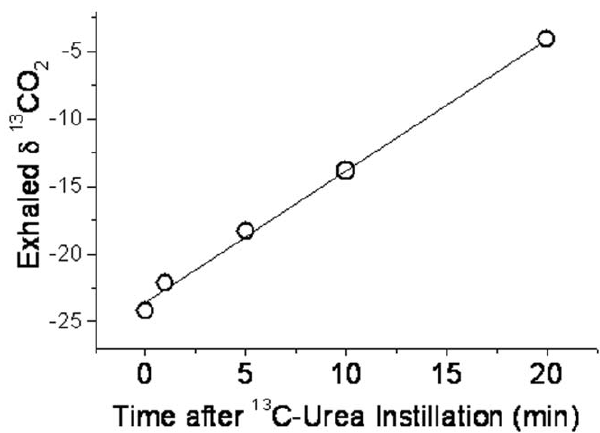
Figure 3. Exhaled d 13 CO 2 increased linearly after urea instilla- tion. Breath samples were obtained prior to, and 1, 5, 10 and 20 minutes after urea instillation. Fig 3 shows typical data from a heavily infected rabbit.